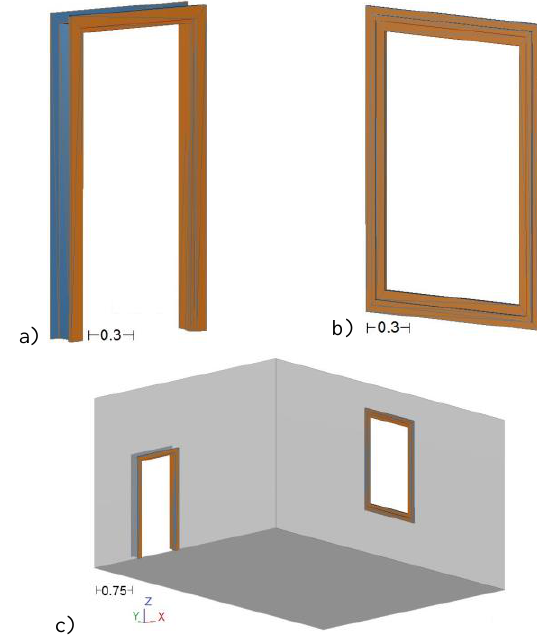
Figure 13. Reconstructed meshes of door (a) and window (b), and (c) visualization in a 3D scene using